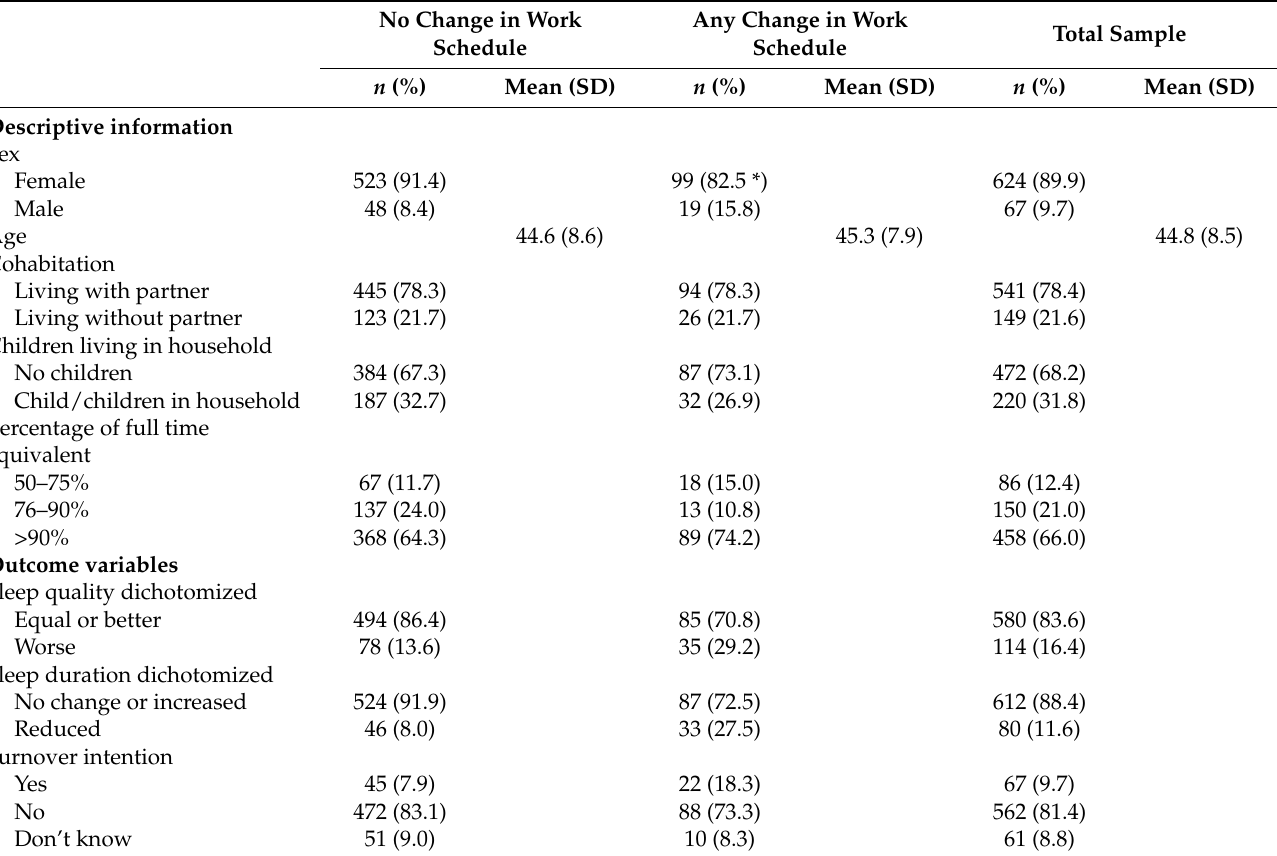
Table 1. Demographics and characteristics among nurses ( n =